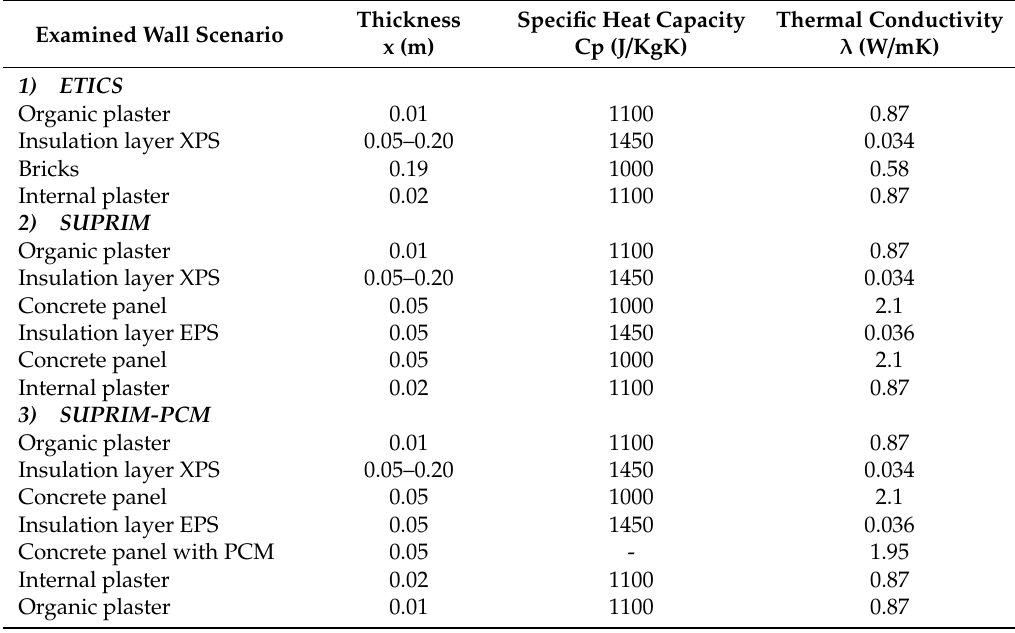
Table 1. Geometrical and thermophysical parameters of the building envelope materials of the examined vertical walls (starting from the outside towards the inside